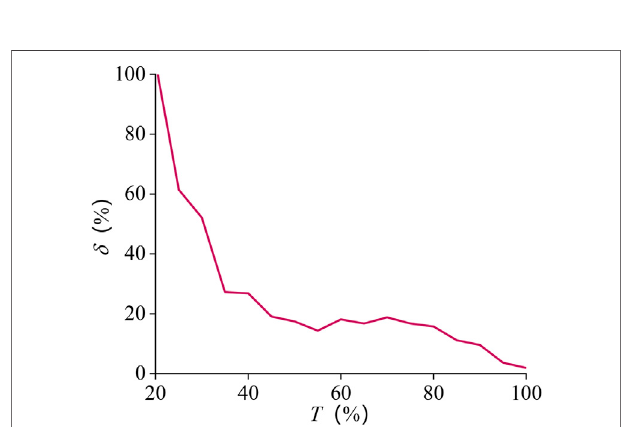
FIGURE 12 | Relative error curve of pronation – supination movement